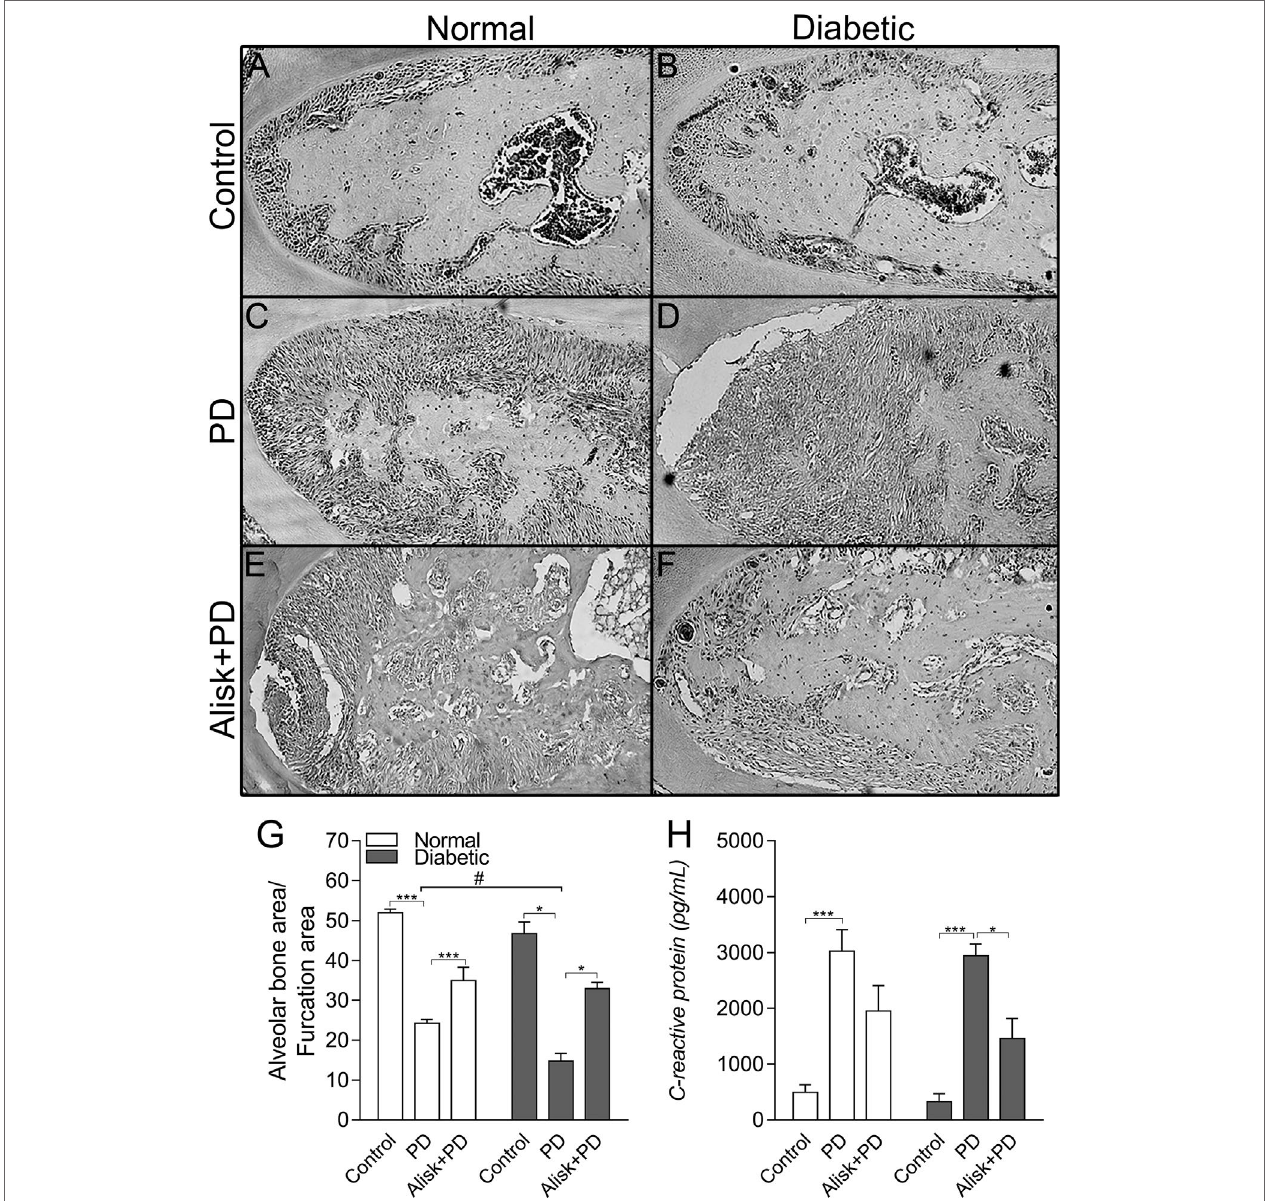
FIGURE 1 | Renin contributes to the periodontal bone loss and inflammation response in normal and diabetic mice 14 days after PD. Histological sections of the lower first molars from the normal mice [control (A) , normal with PD (C) , normal with PD treated with aliskiren (Alisk) (E) ], diabetic mice [control (B) , diabetic with PD (D) , and diabetic with PD and treated with Alisk (F) ]. Percentage of alveolar bone area per μm 2 computed using Image J (G) software. C-reactive protein production by gingival fibroblast in normal and diabetic mice 14 days after PD (H) . Data are represented as mean ± SEM (n = 10). Significant values are represented as ***p < 0.001 and *p < 0.05 (Control vs. PD; PD vs. Alisk + PD; and PD vs. PD+Alisk), and # p < 0.05 (diabetic + PD vs normal +